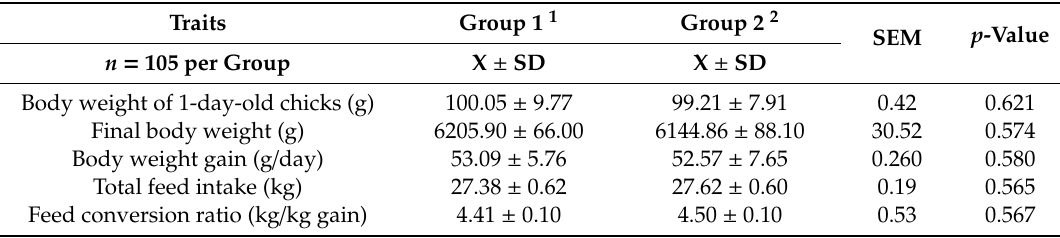
Table 3. Productivity parameters of all of geese (x; ± SD; SEM) after the 16-week rearing period. Traits Group 1 1